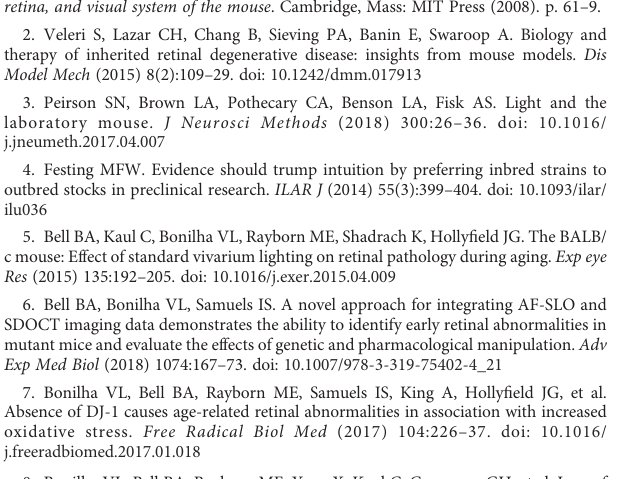
SUPPLEMENTARY FIGURE 1 Illustration of Analysis#4 measurements outer segment signal slope (OSS ∠ ) from LRP SD-OCT B-scans.